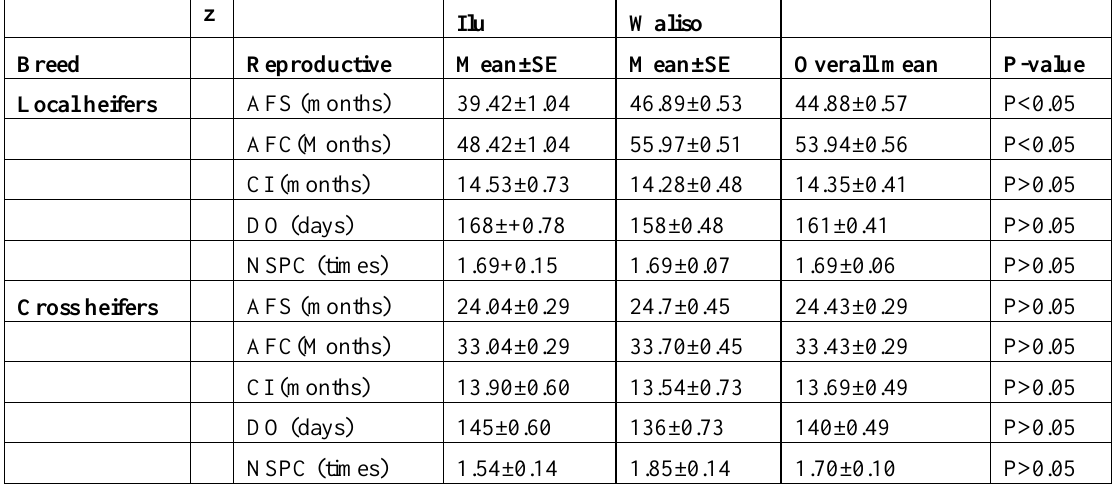
Table 2. Reproductive performance of dairy cattle in the study